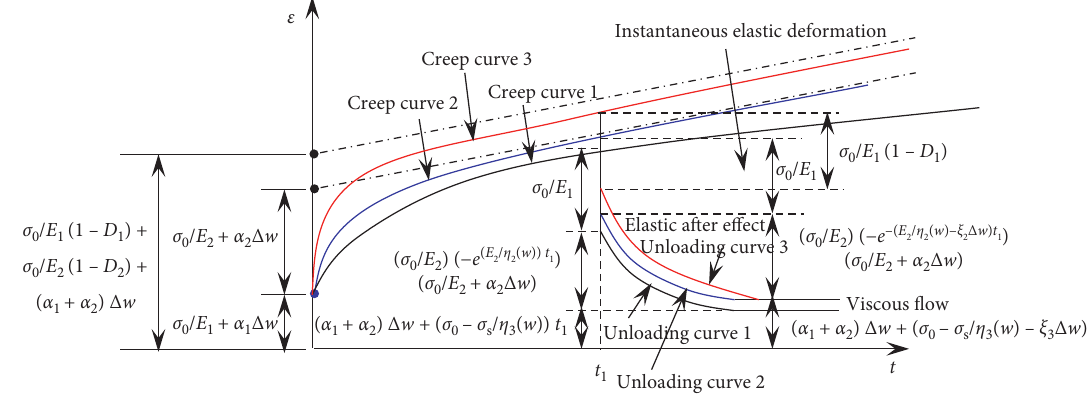
Figure 5: Model curves of creeping and unloading while σ